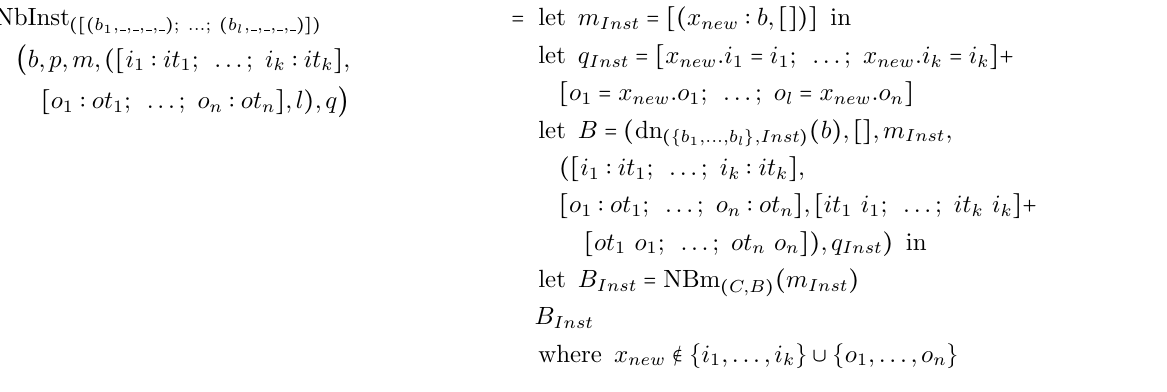
Figure 23: Function NbInst—Create block instance wrapper